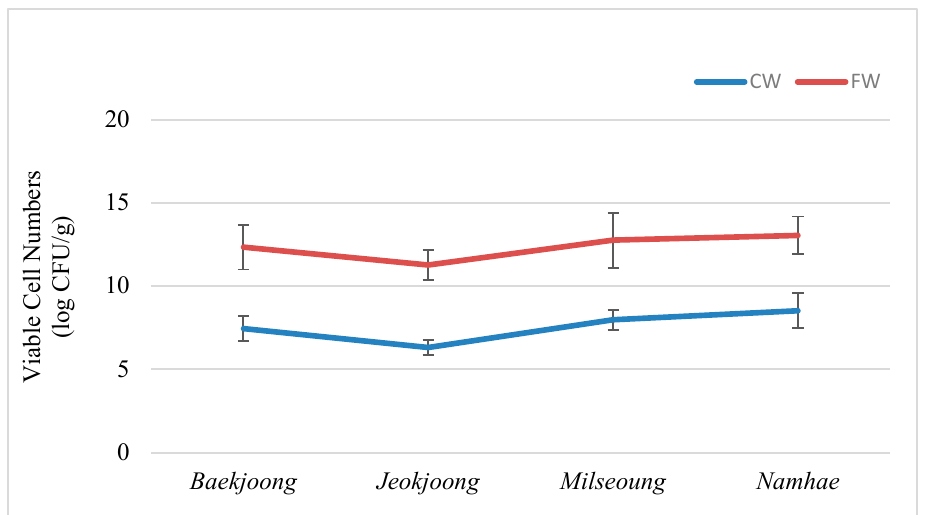
Figure 1. Viable cell numbers of cooked wheat and fermented wheat. Error bars (mean ± SD) represent significant differences among the treatments. The data were analyzed with a one-way ANOVA followed by Duncan multiple range tests ( p < 0.05). CW: cooked wheat, FW: fermented wheat.